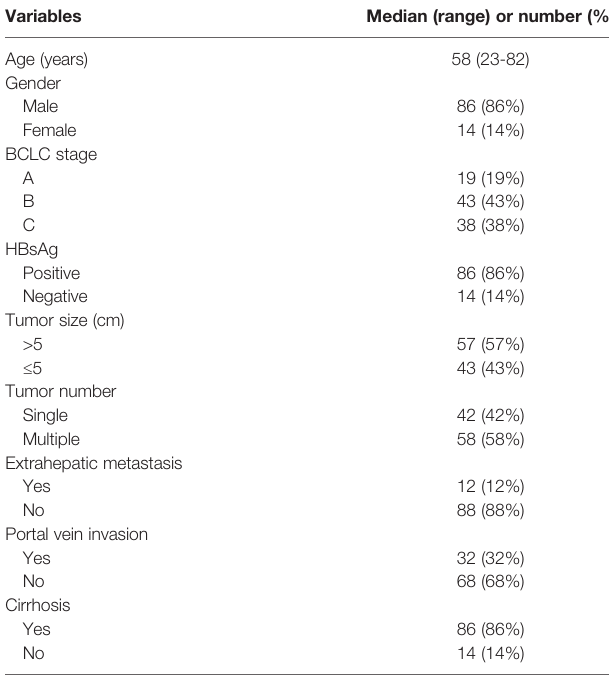
TABLE 1 | Characteristics of 100 patients with hepatocellular carcinoma treated with transarterial